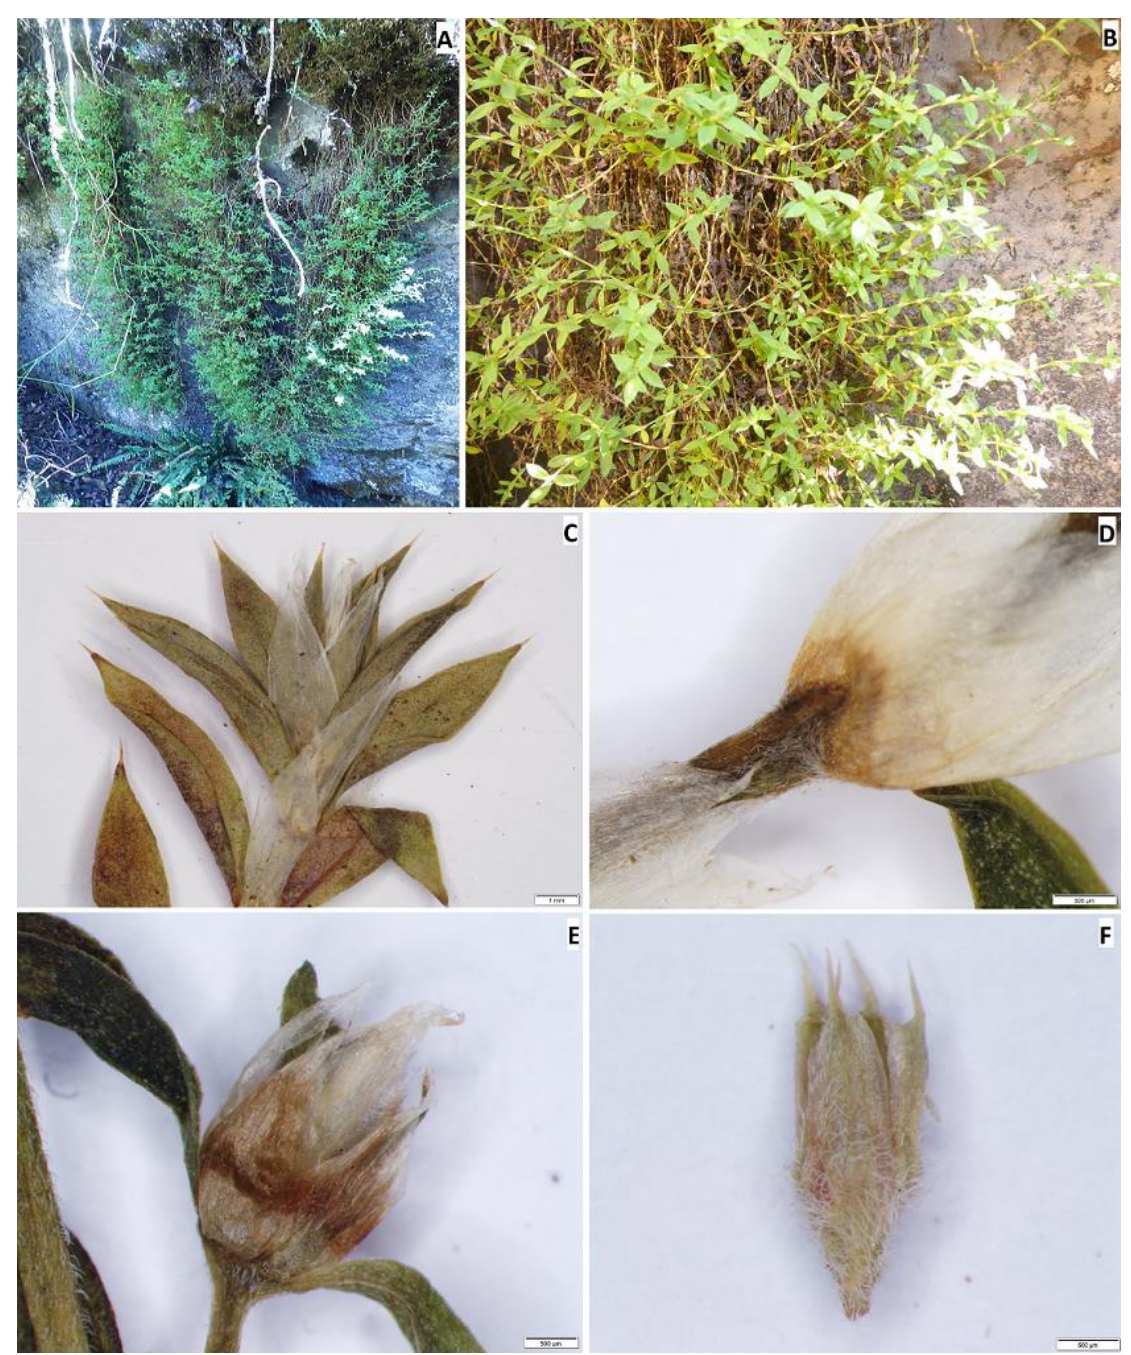
Figure 3. Paronychia glabra . ( A ) Habit of the species in rock crevices and karstic caves, Tajopampa, Chachapoyas, Amazonas, 3670 m, ( B ) branches showing the internodes, leaves, and stipules, ( C ) branch bearing glabrous leaves and notable stipules, ( D ) base of the node where the leaves and stipules are born, ( E ) stipules densely covering a single flower, ( F ) flower calyx. Photos: DBMT.